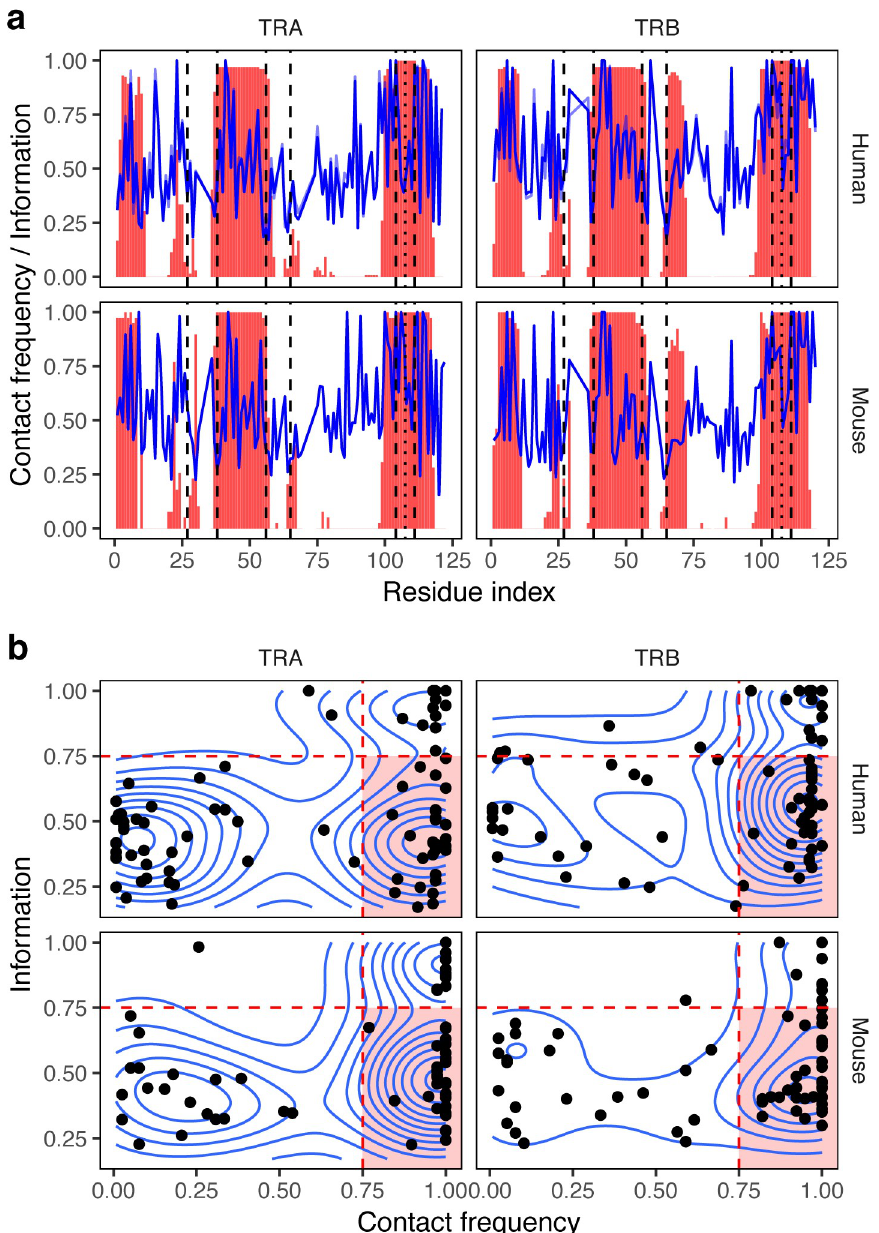
Fig 2. Variability and contact frequency of TCR chain residues. a. Contact frequency (red bars) and information content (blue line) across α and β chains. For human, transparent blue line shows information content computed from residue frequencies weighted by corresponding V and J gene usage in donor repertoires. Dashed lines show FR-CDR boundaries. b. Scatter plot represents the probability of being involved in inter-chain contact (x axis) and information content of amino acid frequency distribution (y axis) for individual α and β chain residues. Region with a selection of frequently contacted residues ( x > 0 . 75 ) that are have variable amino acid content ( y < 0 . 75 ) is highlighted with a red background. Residues with more information content should be considered as less variable, residues having no inter- chain contacts are not shown.